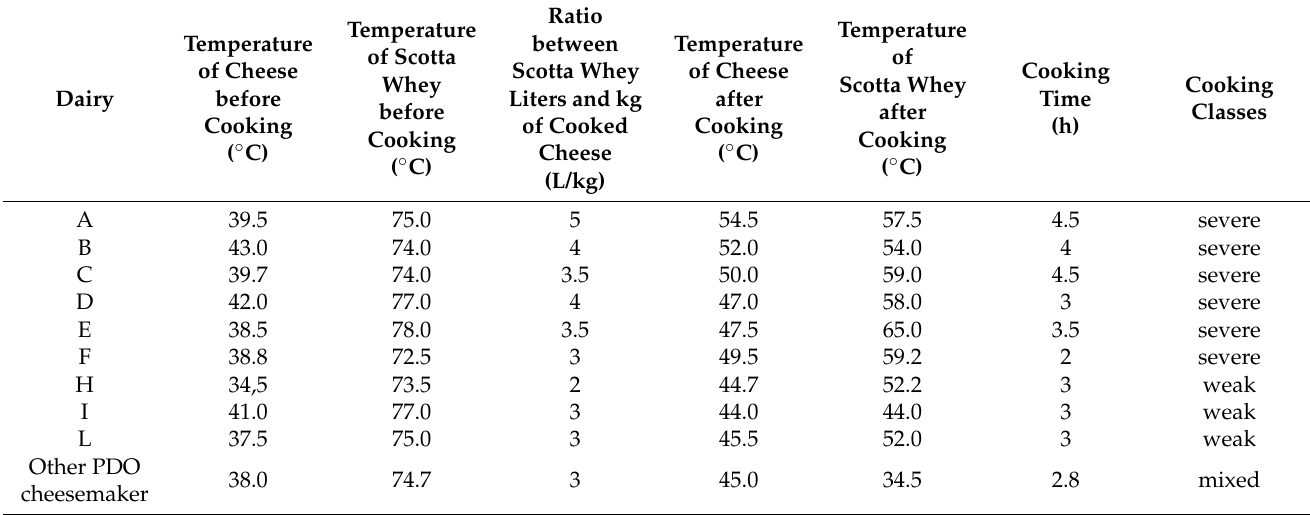
L 37.5 Other PDO cheesemaker